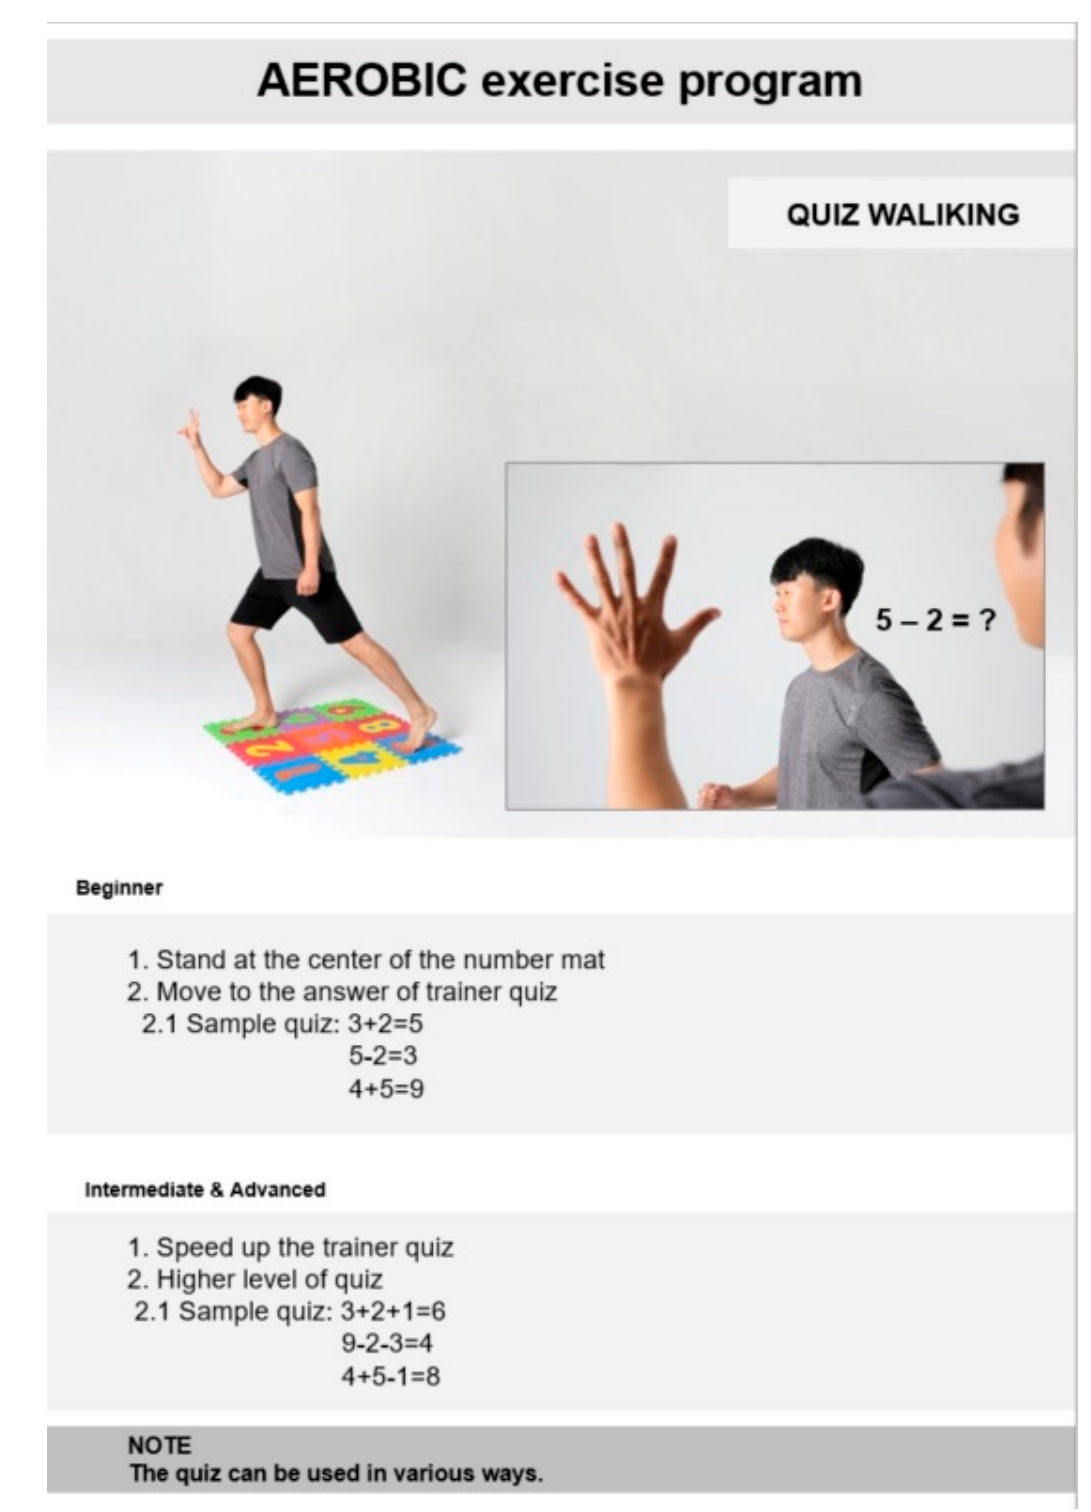
Figure A3. Detailed description and components of each movement in the “Quiz walking” aerobic exercise.